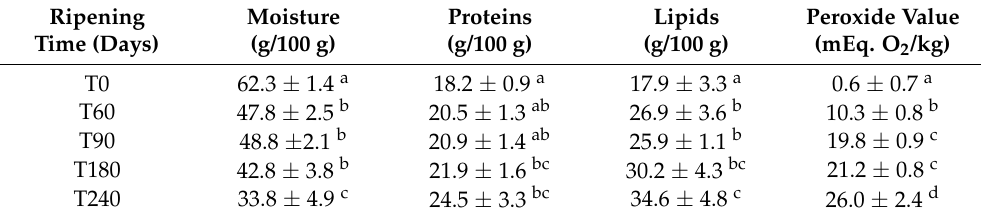
Table 1. Effect of ripening time on moisture, protein, lipid and peroxide value of Coppa Piacentina PDO. Results are the mean of five independent analyses. Ripening Time (Days)